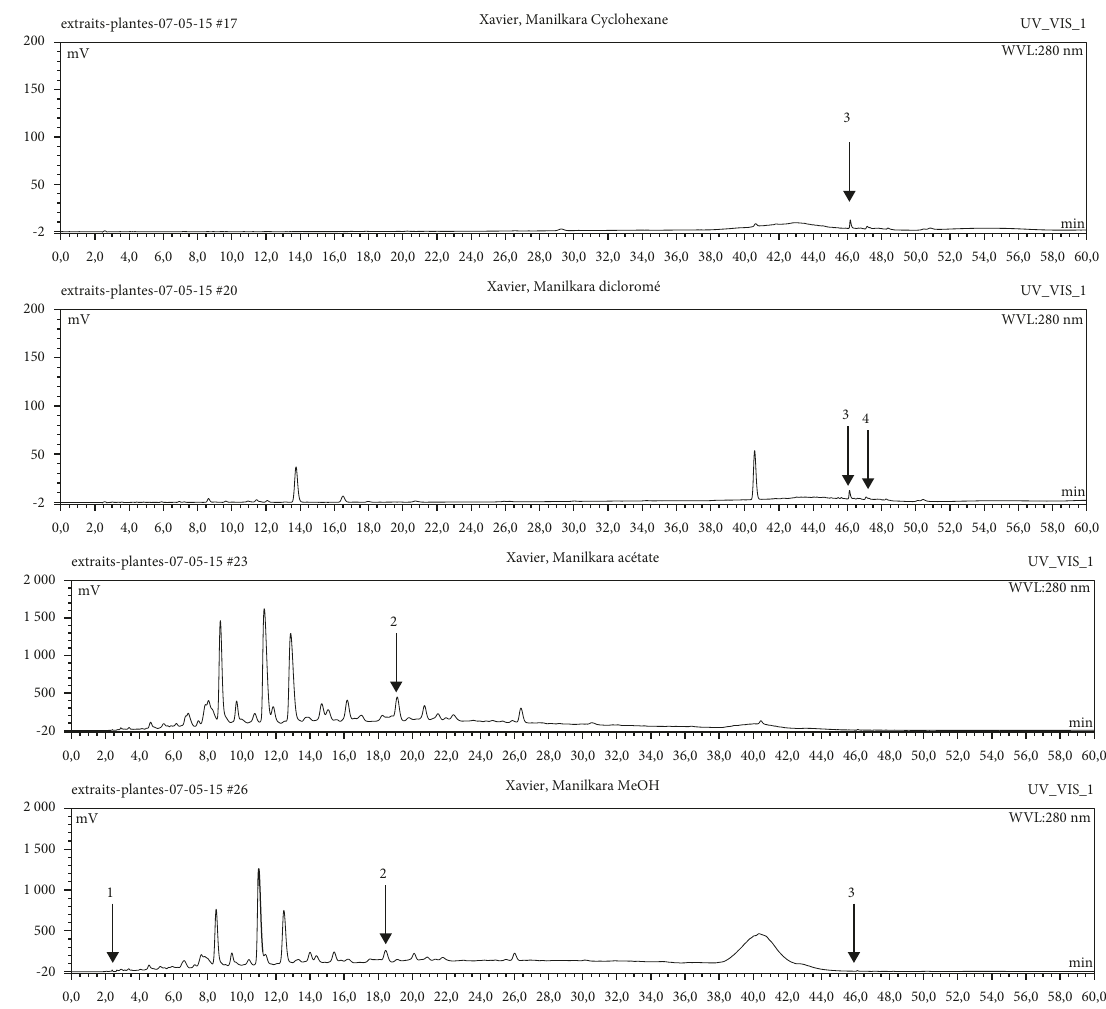
Figure 1: HPLC chromatograms of M. mabokeensis Aubr´ev bark extracts. CYHA: cyclohexane; DCM: dichloromethane; EtOAc: ethyl acetate; MeOH: methanol. Peaks: (1) 3-amino-4-hydroxybenzoic acid; (2) L-tyrosine 7-amido-4-methylcoumarin; (3) 4-hydroxy-3-pro- pylbenzoic acid methyl ester; (4) 3,6,3